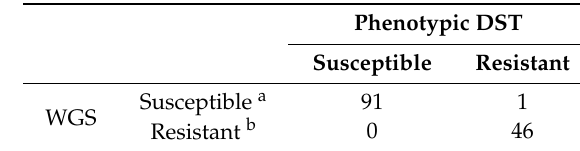
Table 4. Agreement between phenotypic DST results and identified aa exchanges in the gyrA gene at codon 87 and/or 91 conferring resistance to fluoroquinolones ( N = 138).